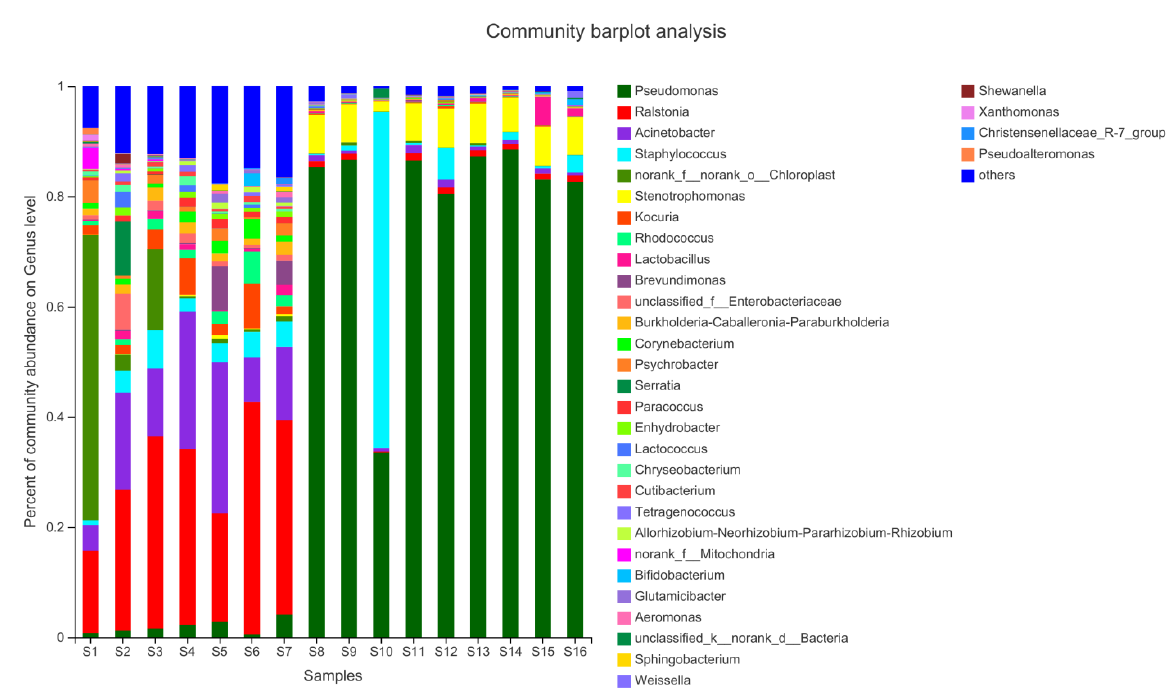
Figure 2. Relative abundance of bacteria at the phylum level in the samples.